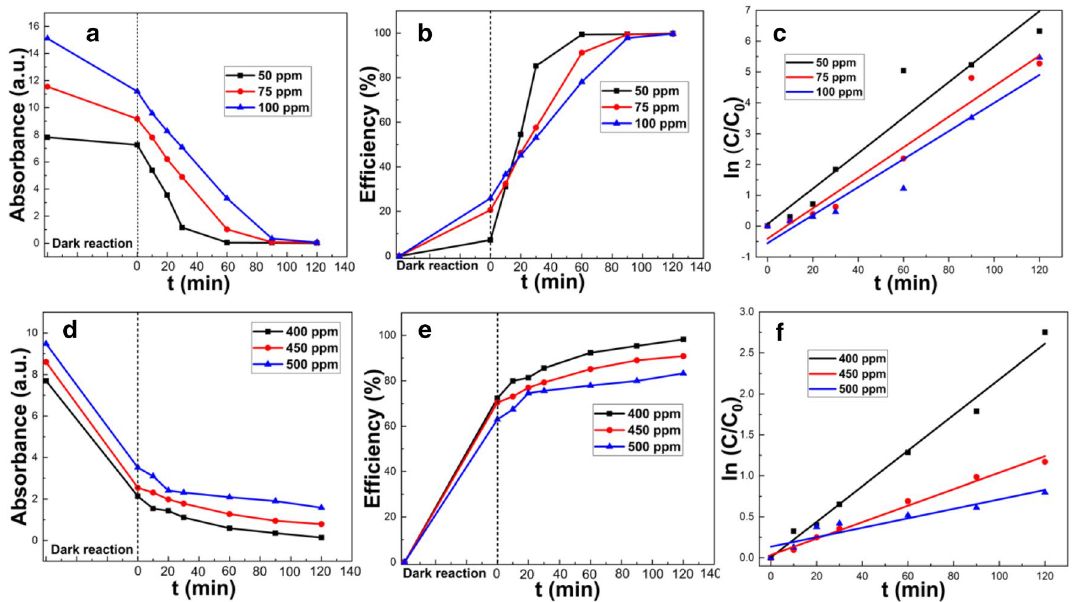
Figure 6. Photocatalytic experiment of clam shell at 1000 °C for MB ( a – c ) and CR ( d – f ); Curves of absorbance with time ( a , d ); Curves of removal rate with time ( b ), ( e ); Plots of log of concentration with time ( c , f